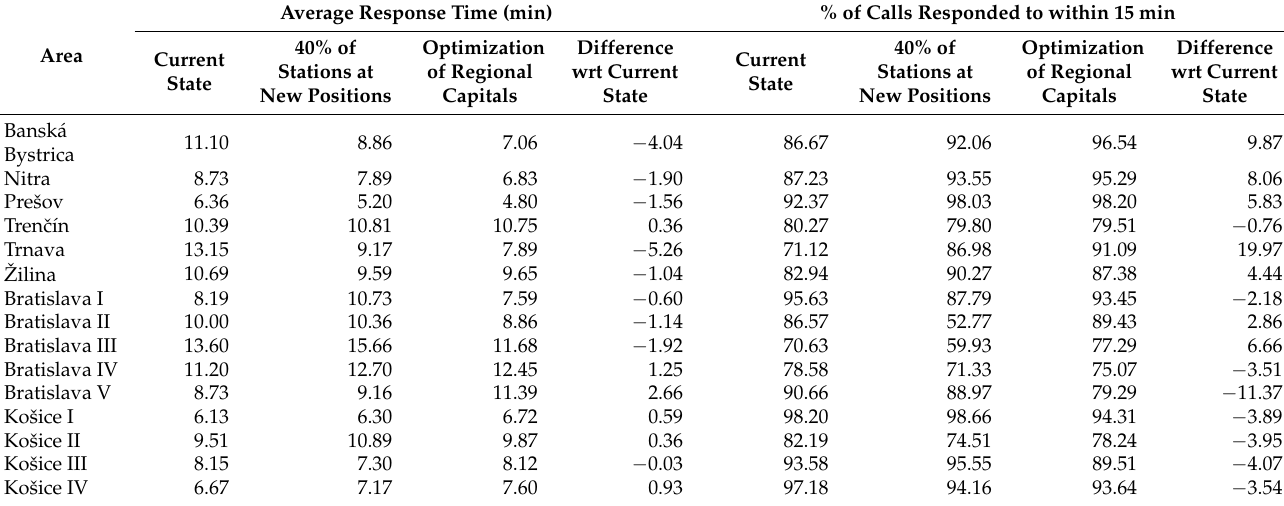
Table 6. Performance indicators with respect to all patients regardless of their